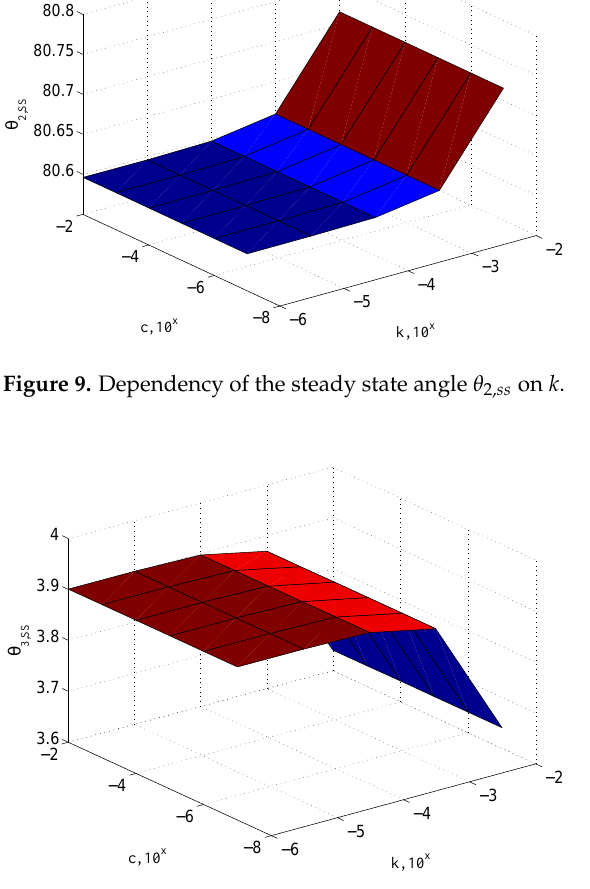
Figure 10. Dependency of the steady state angle θ 3, ss on k